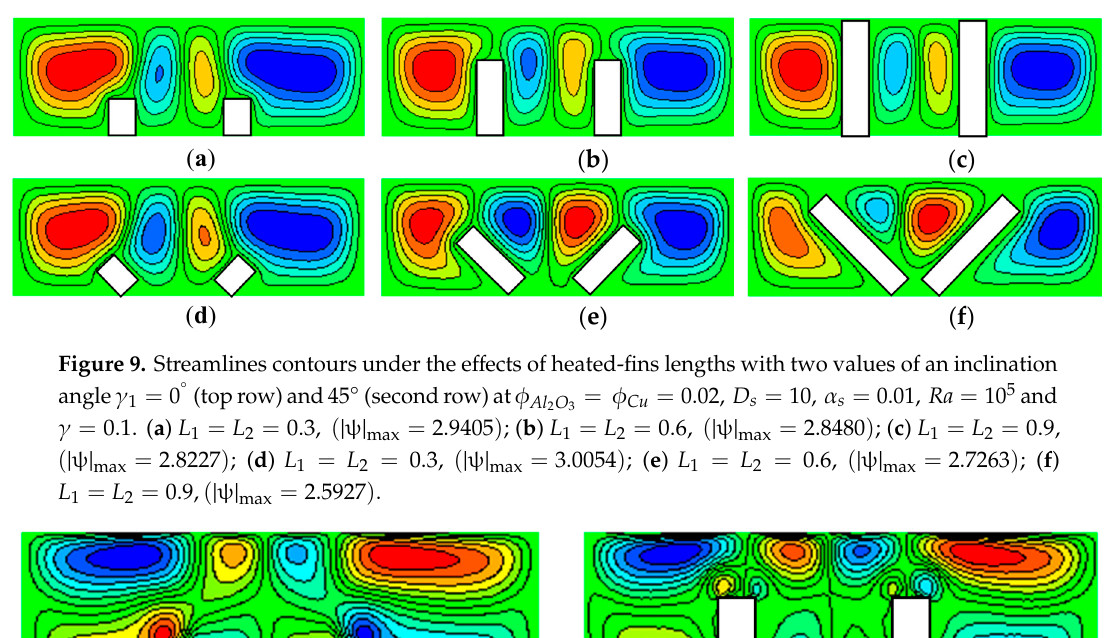
0.6 ; ( f ) 𝐿 (cid:2869) = 𝐿 (cid:2870) = 0.9 .